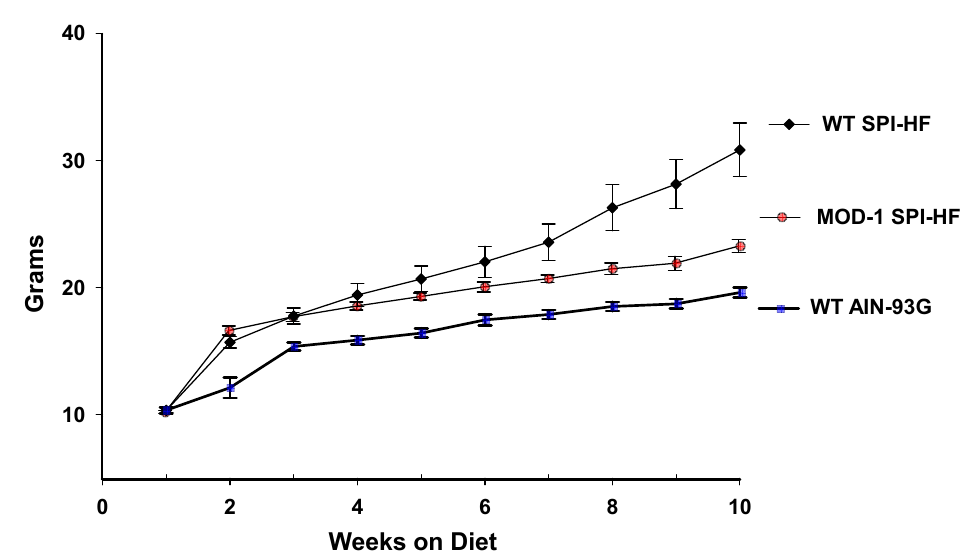
Figure 1. Body weights (mean ± SD) of female mice on each diet ( n = 10 WT AIN-93G; n = 10 WT SPI-HF; n = 11 MOD-1 SPI-HF) over a ten week period. By week seven, the three groups significantly differed from each other ( p < 0.05), and this trend continued until week ten ( p < 0.05 for each pairwise comparison).